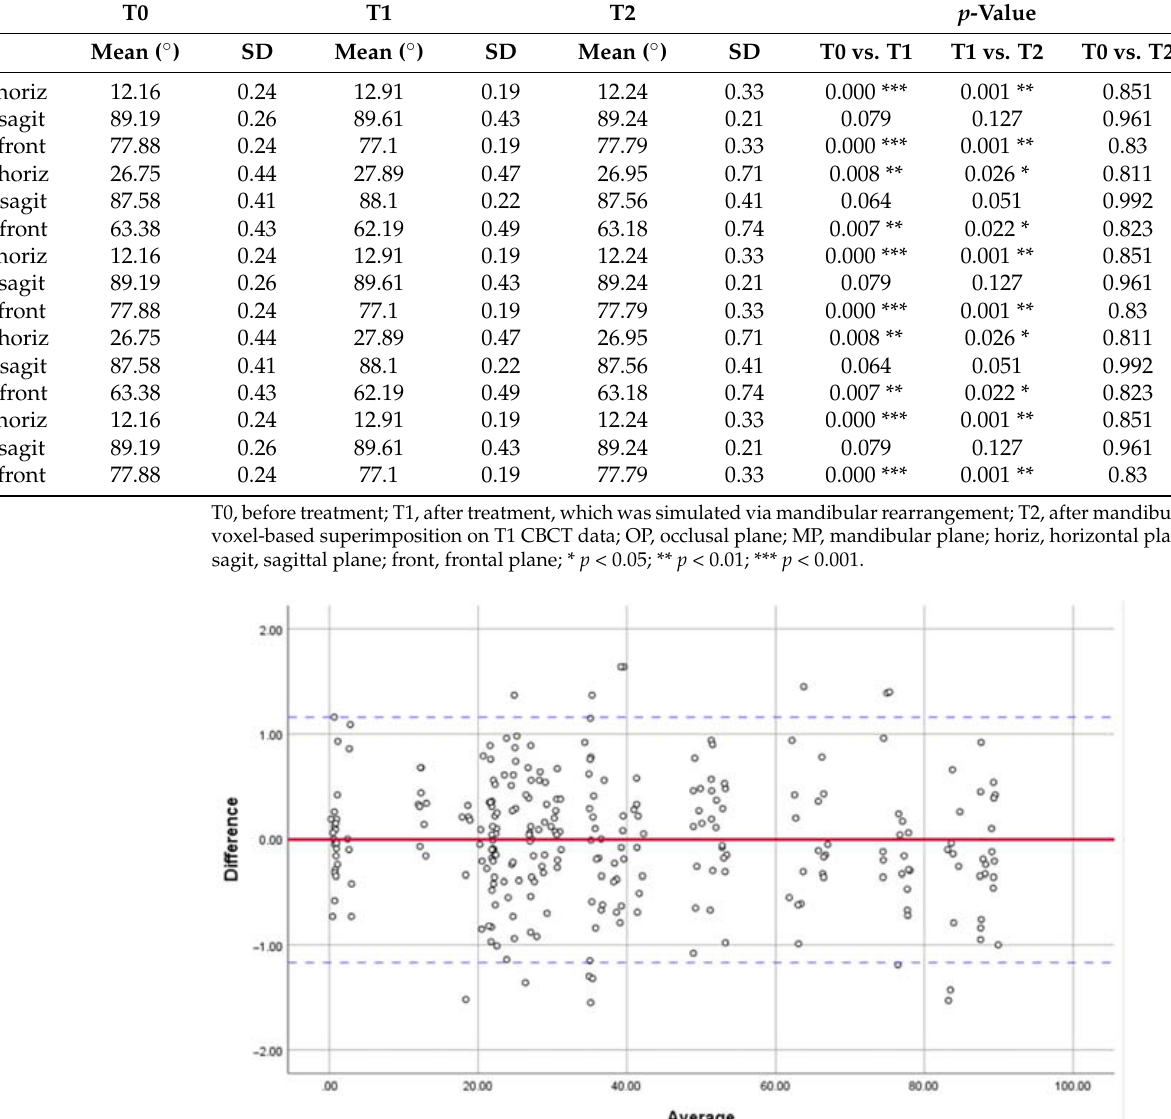
Table 6. Angular changes in mandibular measurement planes at T0, T1 and T2.